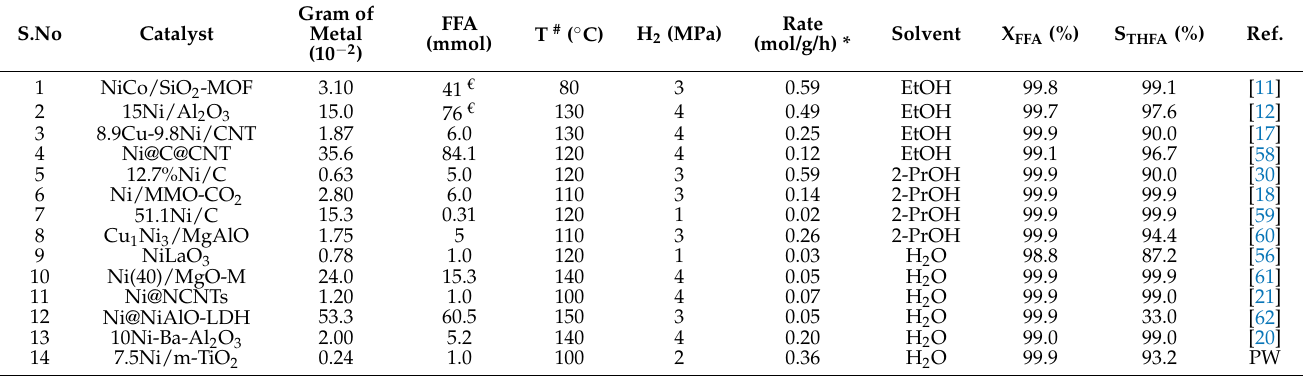
Table 2. Comparison of Ni-based catalysts reported in the literature on FFA hydrogenation to